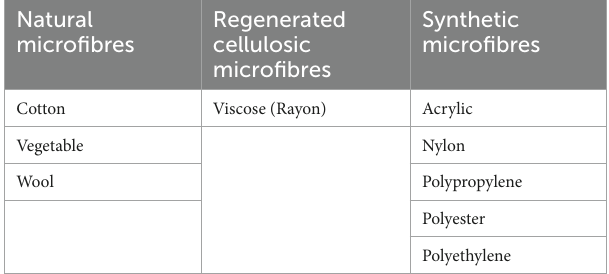
TABLE 1 Classification of microfibre types found in present